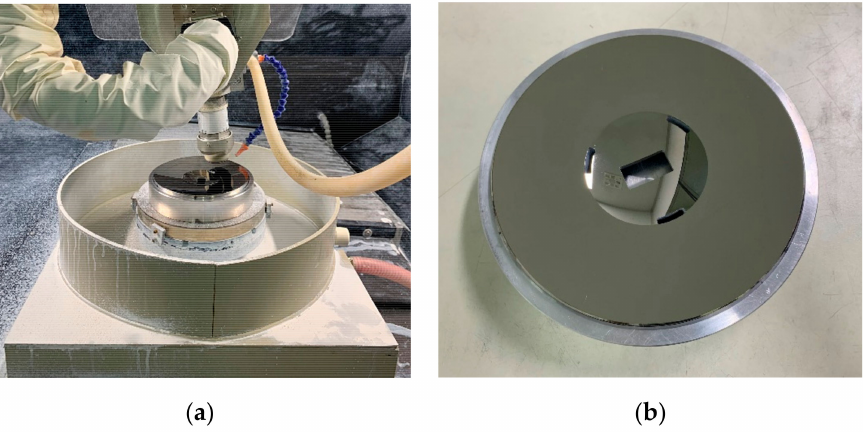
Figure 13. ( a ) The mirror on the OptoTech polishing machine; ( b ) the final mirror in the tool disk.